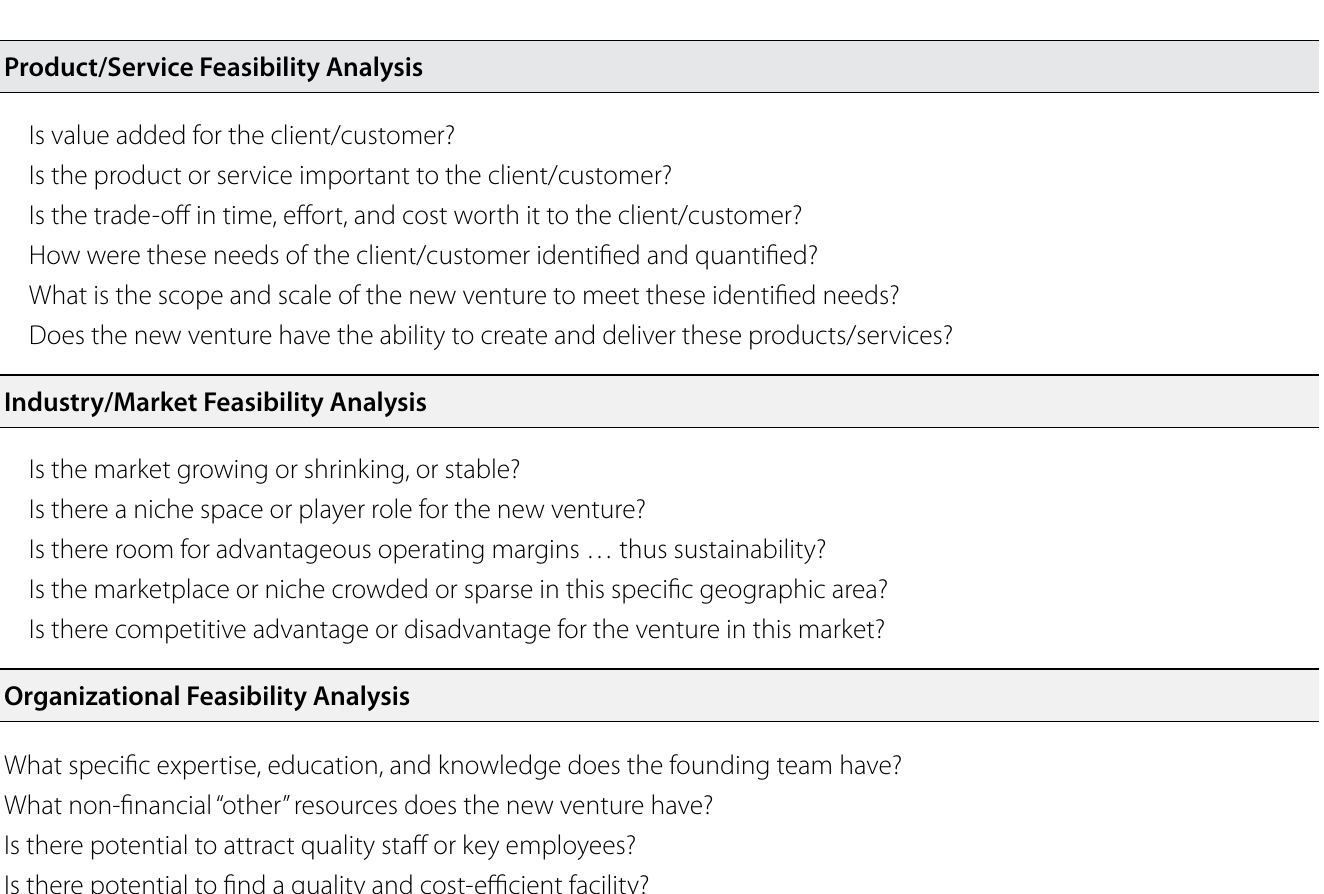
Table 3. Questions Asked During Feasibility